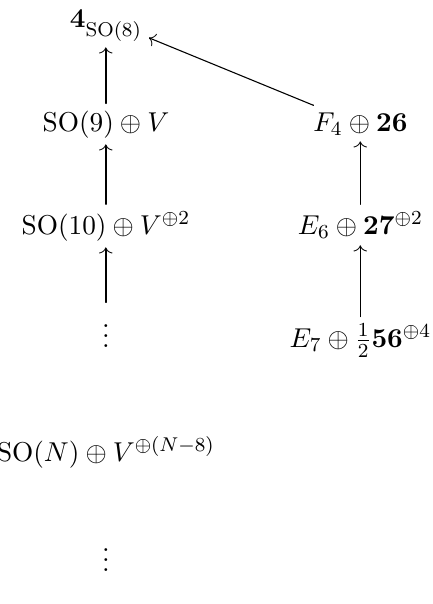
Figure 3. The Higgsing tree for 4